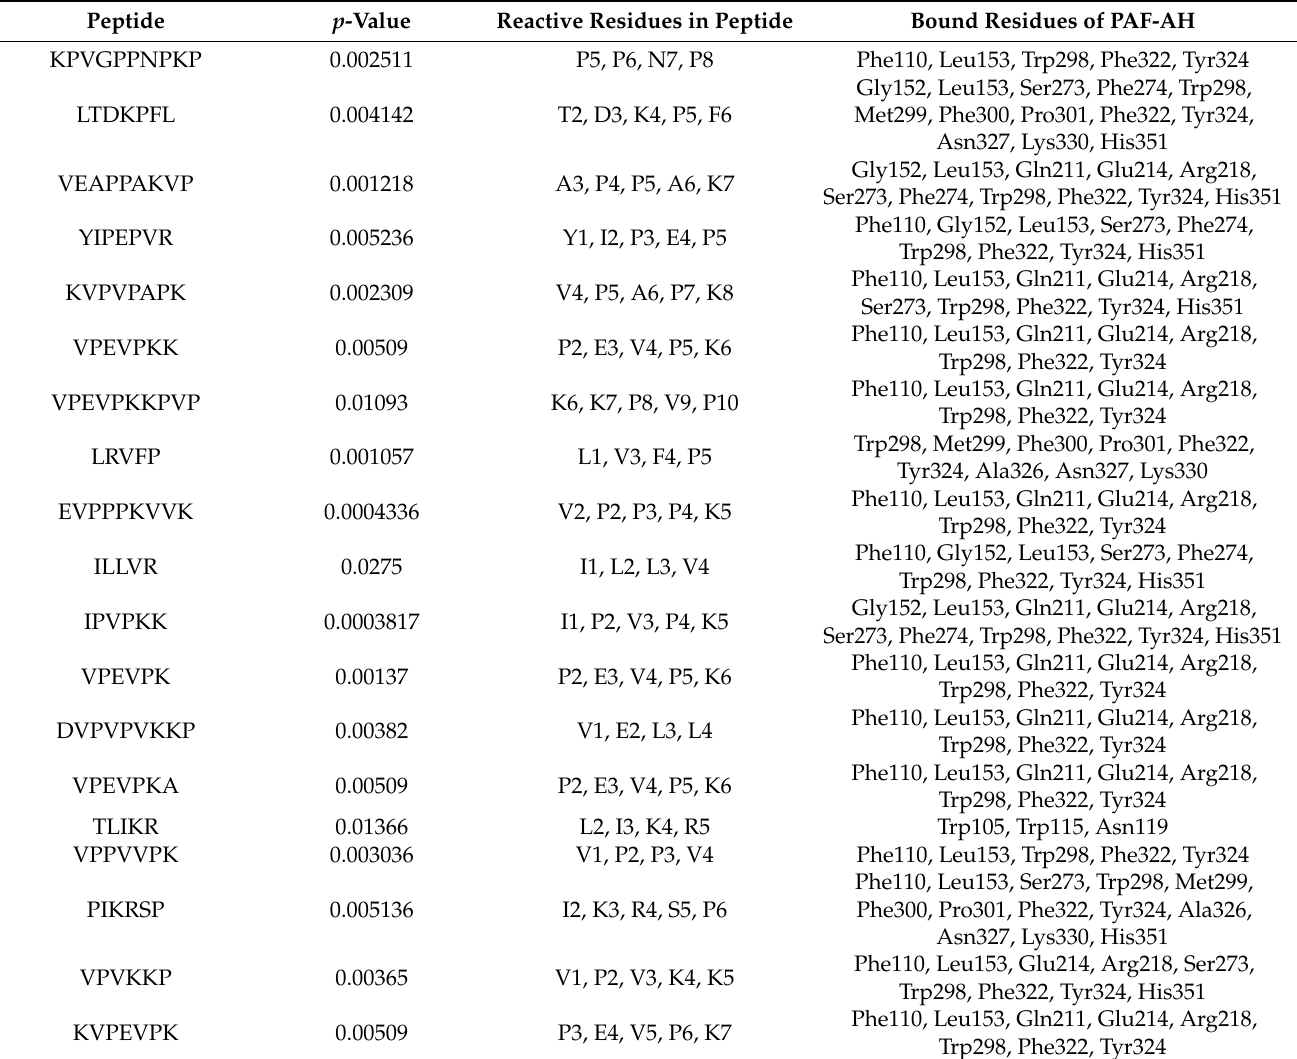
Table 2. Dry-cured-pork-coppa-derived peptides and their binding potential with PAF-AH as protein